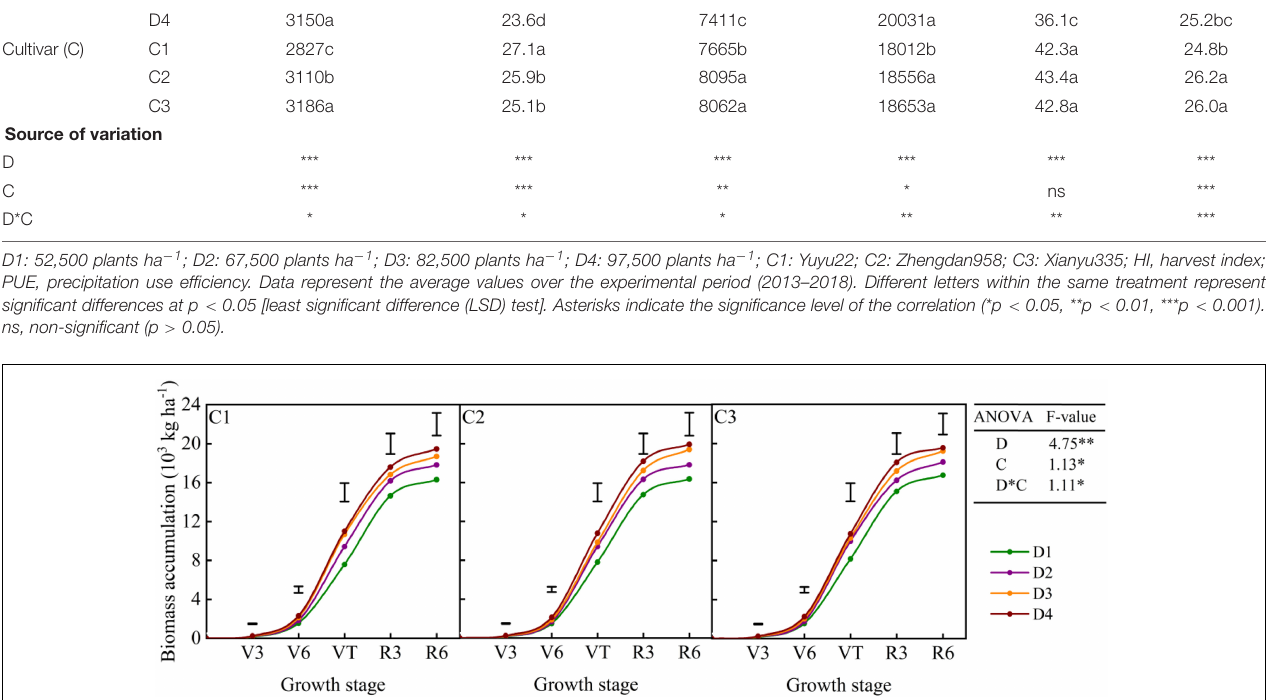
Frontiers in Plant Science |